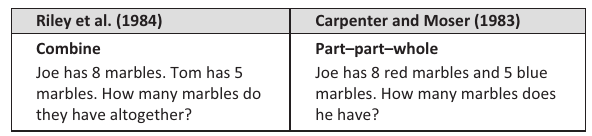
FIGURE 3: Comparison of ‘combine’ and ‘part-part-whole’